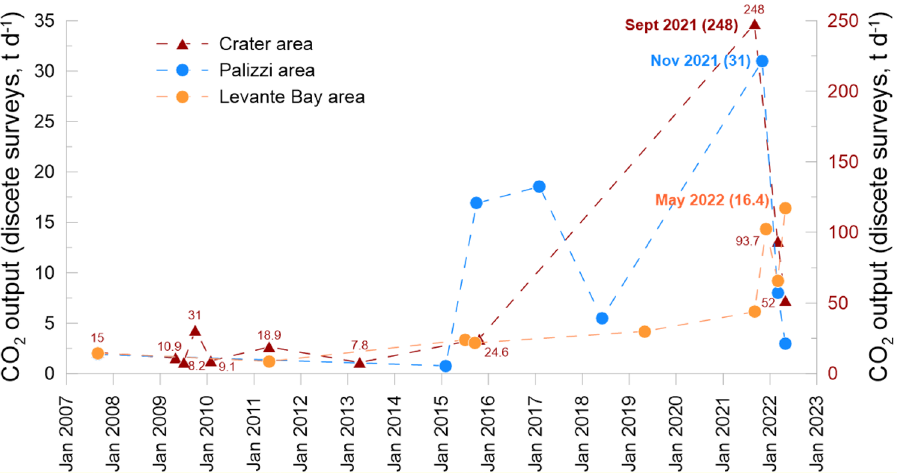
Figure 6. Time variation of soil CO 2 output from Crater and peripheral areas of Levante Bay and Palizzi evaluated by periodical surveys (red triangles, brown circle and blue circles respectively). The maximum outgassing occurred in September 2021 at Crater area with 248 t d −1 and in November 2021 at Palizzi area with 31 t d −1 , while the outgassing peaked in May 2022 at the Levante Bay area with 16.4 t d −1 .